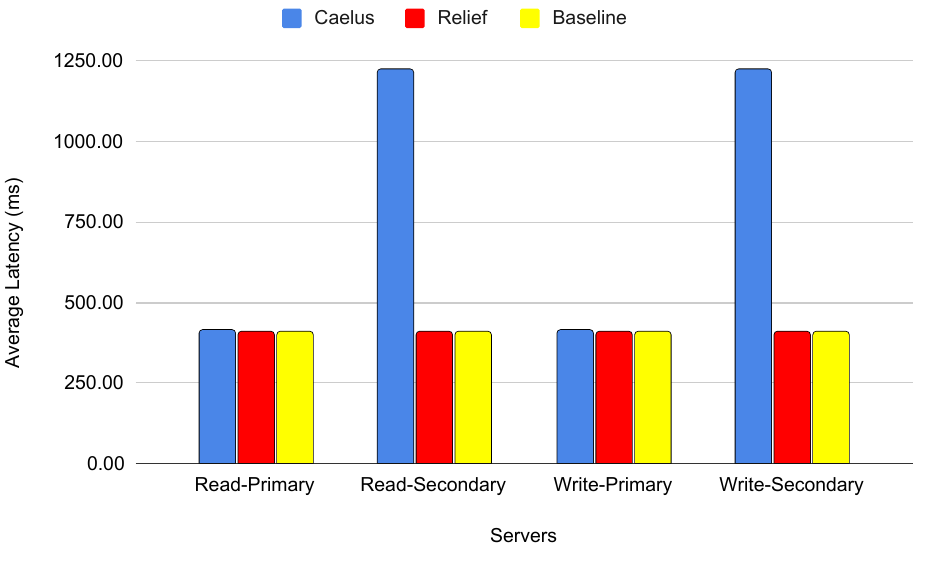
Figure 12. Average